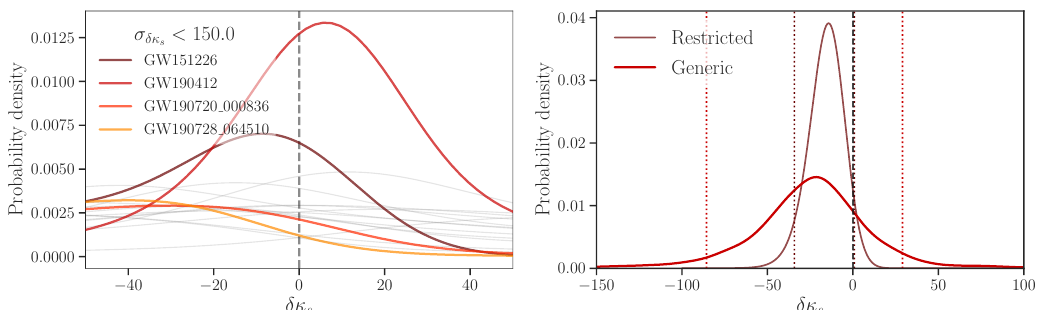
Figure 6. Left : Posterior distributions on the inspiral δκ s for selected events detected through the first, second, and third observing runs of LIGO-Virgo detectors [30]. The events highlighted give better constraints on the δκ s parameter and all the other events considered are shown in grey. The vertical line at δκ s = 0 indicates the BBH value. Right : The bounds obtained on the δκ s parameter from combining information from multiple events. The restricted method assumed universal values of δκ s for all the events. The generic way allows the possibility of varying δκ s among different events according to a Gaussian distribution whose characteristics are obtained from the